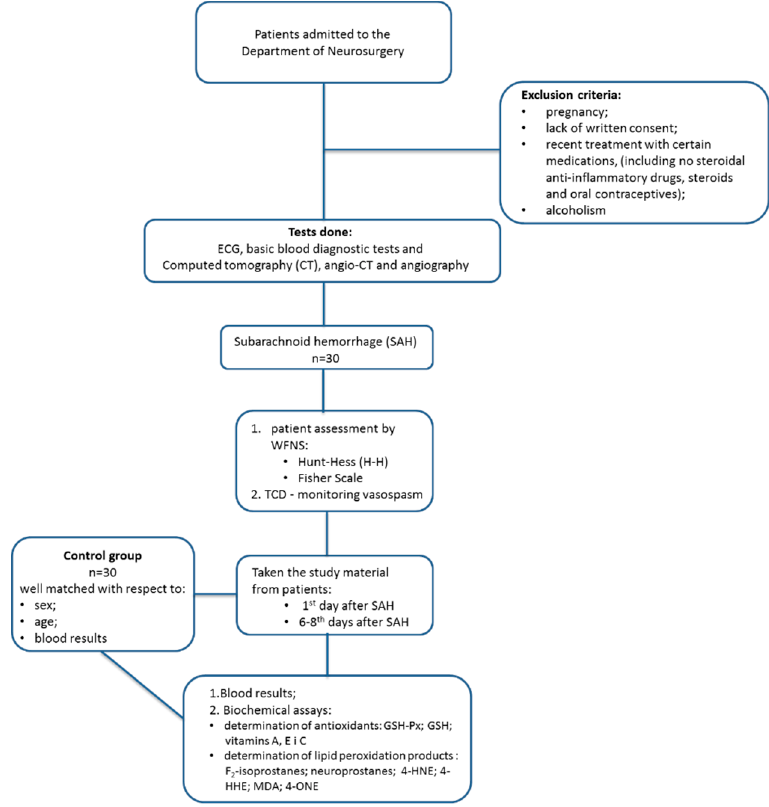
Figure 3. Flowchart of the study.